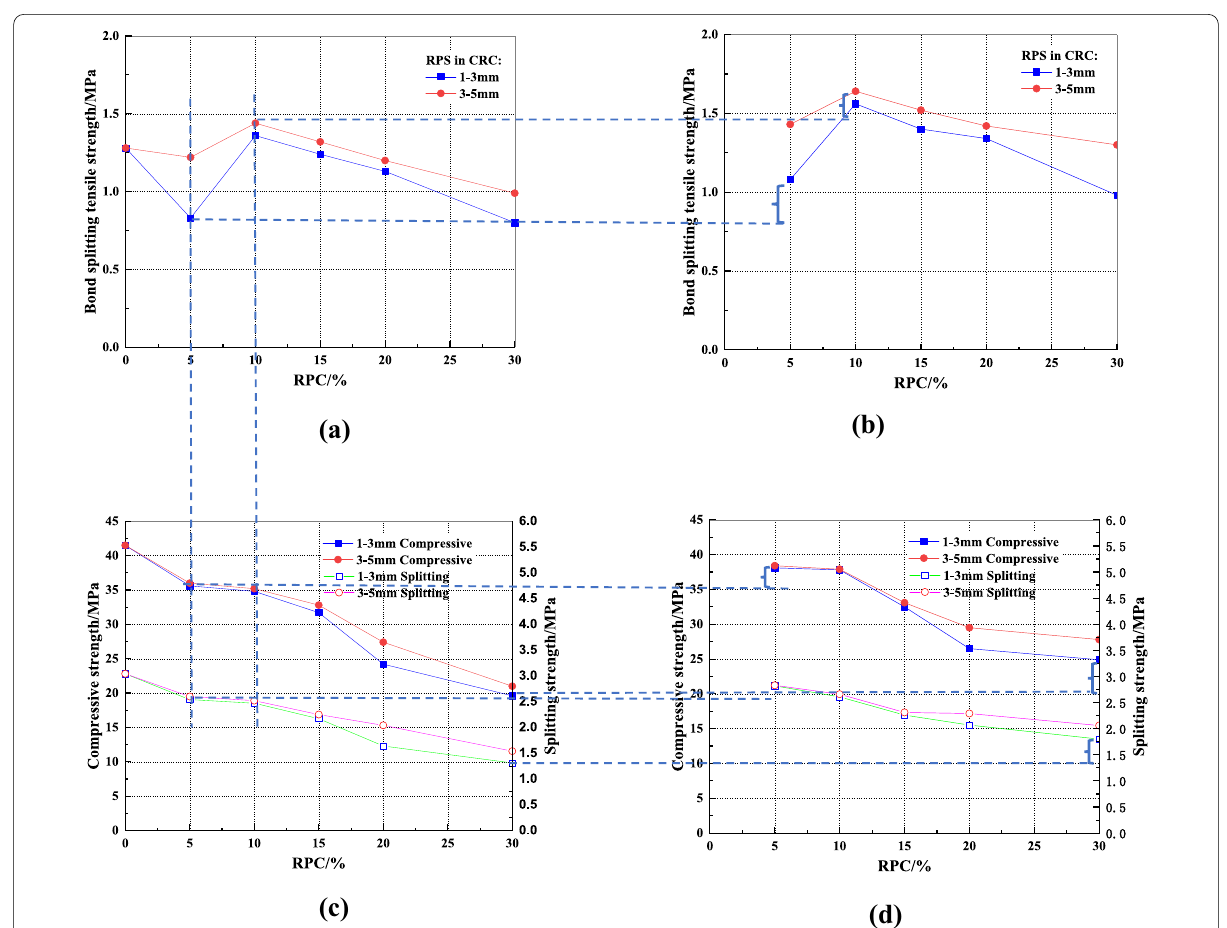
Fig. 7 Relationships between the bond splitting tensile strength of the specimens, the body strength of the specimens, and the RPs content in the RC: a relationship between the bonding splitting tensile strength of the specimens with unmodified RPs and the RPs content in the RC; b relationship between the bonding splitting tensile strength of the specimens with modified RPs and the RPs content in the RC; c relationship between the body strength of the specimens with unmodified RPs and the RPs content in the RC; d relationship between the body strength of the specimens with modified RPs and the RPs content in the RC.